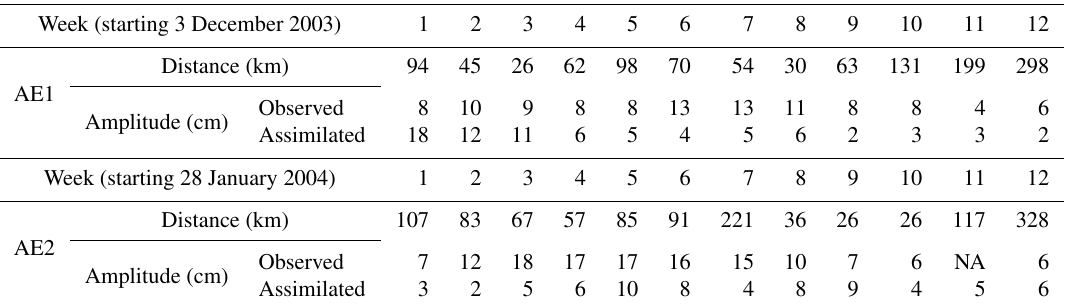
Figure 7. The same as Fig. 6, but for AE2; the corresponding period is 28 January 2003–14 April 2004. Table 1. The amplitude of AE1 and AE2 derived from observation SLA and the assimilation SLA, and distance of eddy centers between the observation SLAs and assimilation